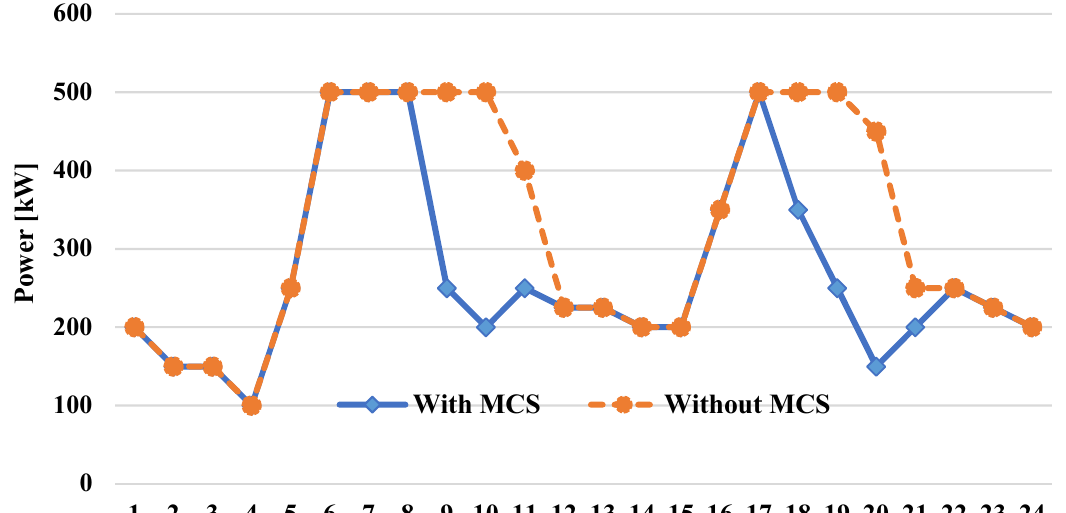
Figure 12. Hourly power drawn from the grid at the fixed charging station bus location. The hourly output power of the up-stream substation for the network without MCS and the network with MCS are shown in Figure 13. Accordingly, the substation’s output power has experienced two cycles of the subsequent decrease and increase due to using